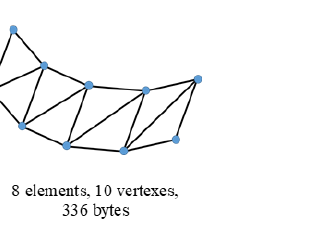
Figure 12. Data size minimization for mirroring type face.